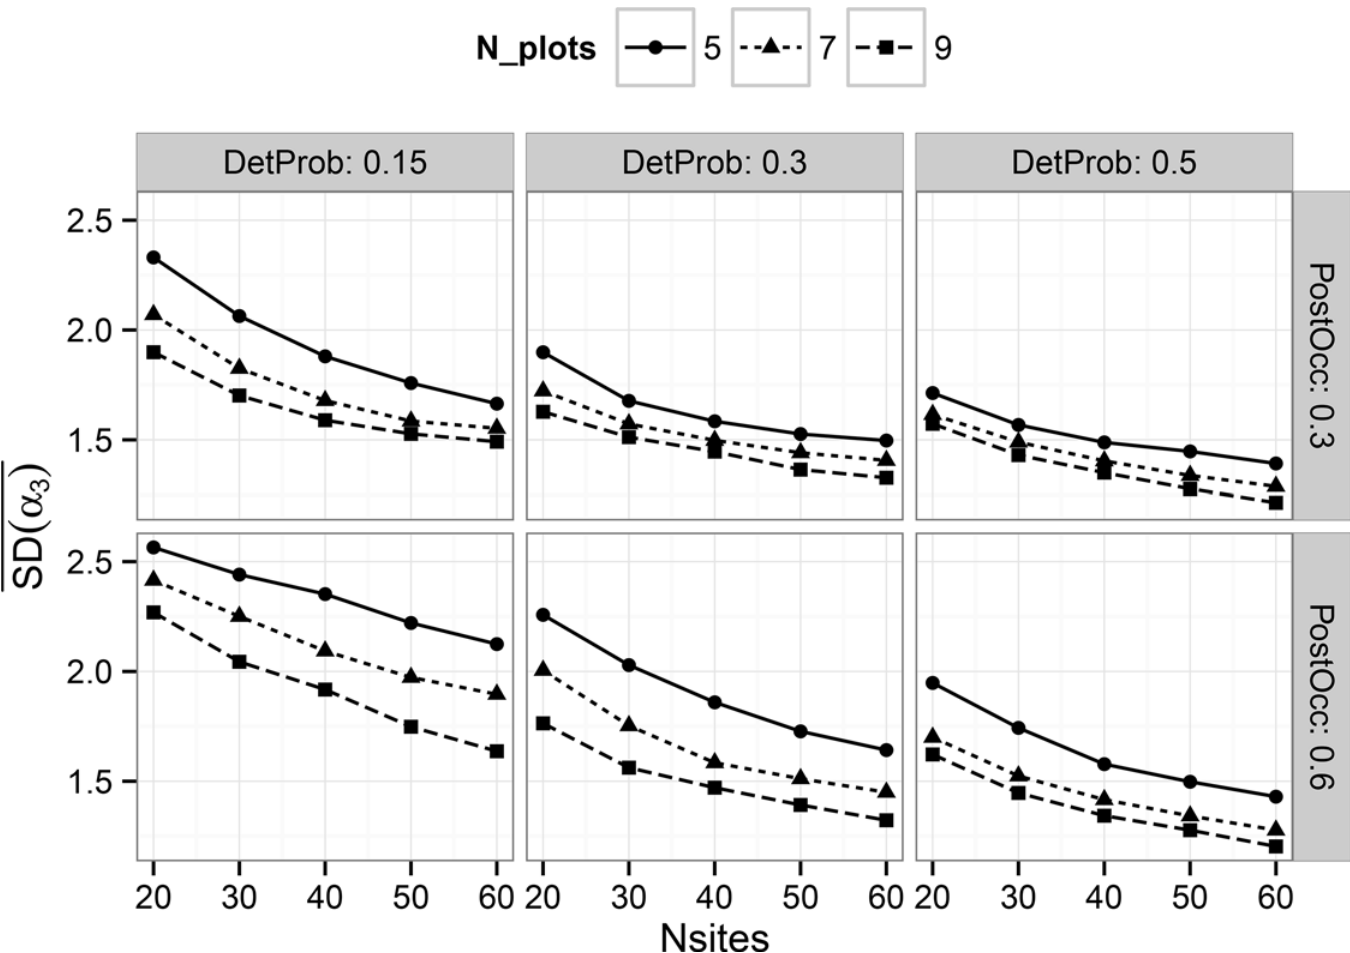
Fig 4. Average standard deviation, by combination, of all posterior mean estimates of the treatment effect estimator ‘ Alpha3 ’ (see Eq 2) in the multi-scale model. Results are shown on the logit scale. Panels show the results for different combinations by simulated detection probability and post- treatment occupancy.